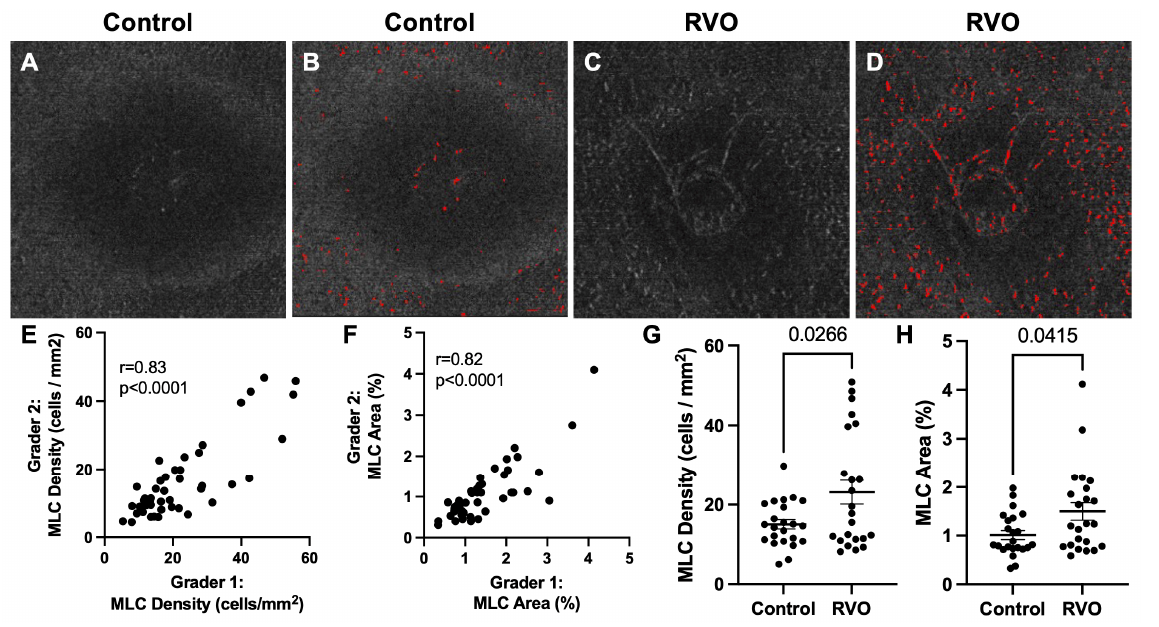
Figure 1. MLCs are increased in RVO eyes. ( A , B ) Representative image of a control eye ( A ) with marked MLCs in red ( B ). ( C , D ) Representative image of an RVO eye ( C ) with marked MLCs in red ( D ). Scatter plots demonstrating inter-rater reliability between two graders for MLC density ( E ) and MLC percent area ( F ). MLC density ( G ) and MLC percent area ( H ) were greater in RVO compared to control eyes.